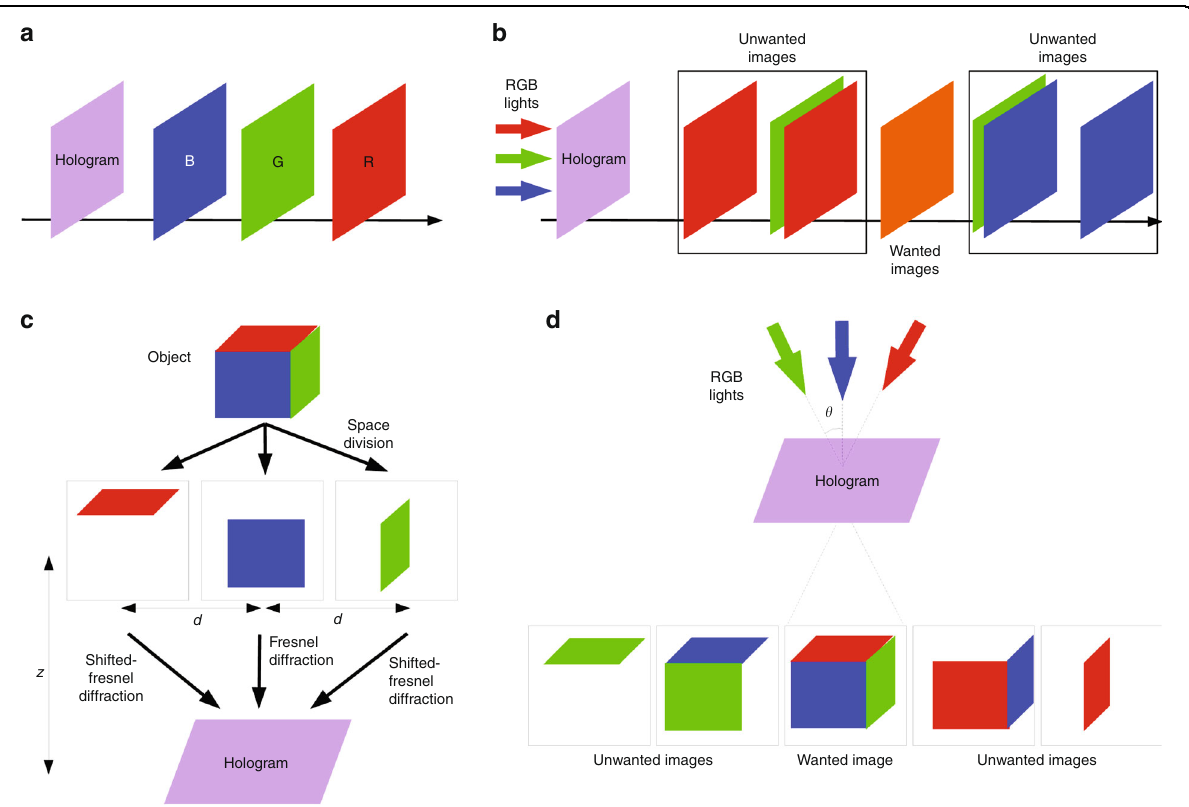
Fig. 9 Recording and reconstruction processes of DDM and SDM. a Recording and b reconstruction processes of DDM; c Recording and d reconstruction processes of SDM, where z is the diffraction distance, d is the distance between each transverse component and θ is the incident angle of the reconstruction light. Reprinted with permission from ref. 151 . ©The Optical